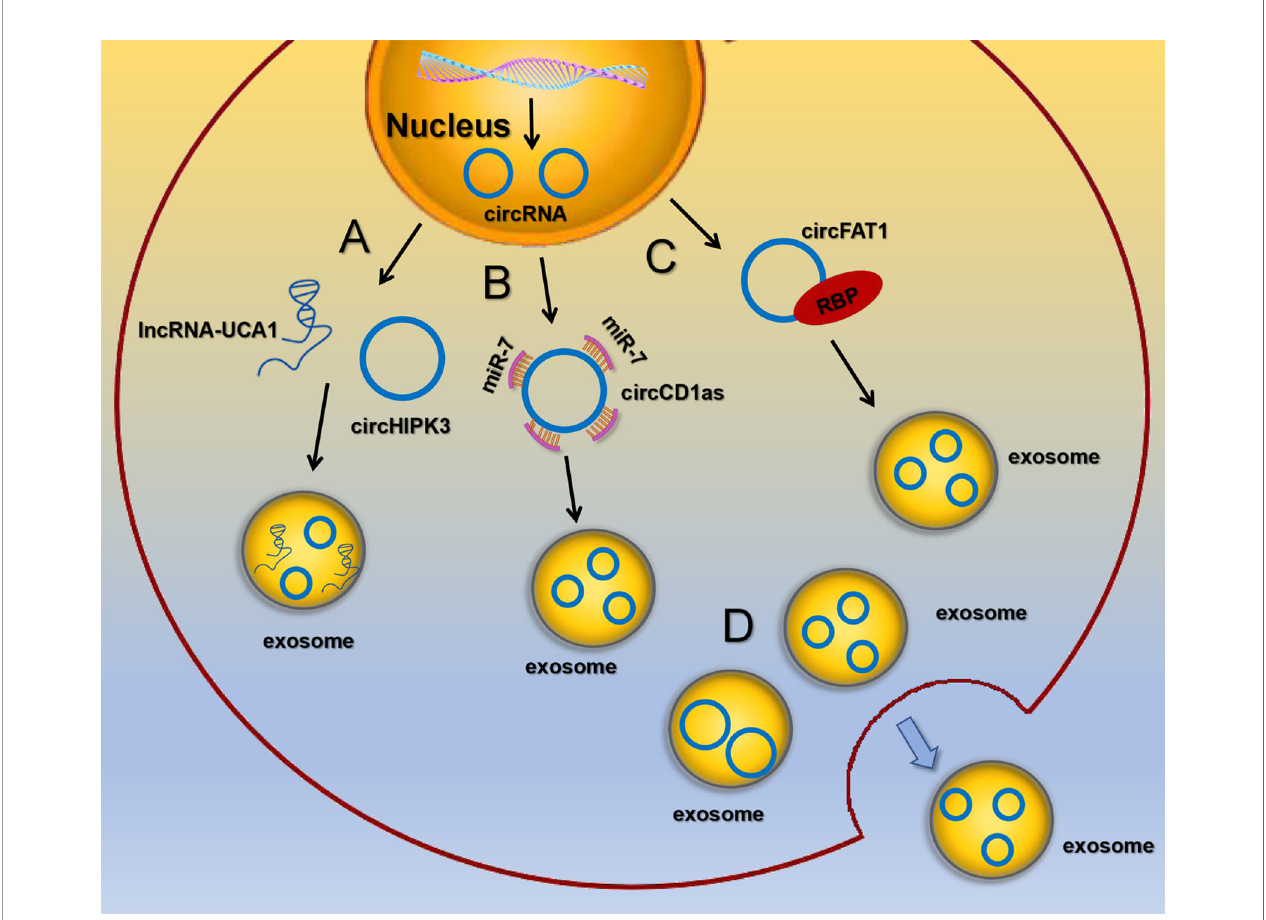
FIGURE 2 | The sorting and secretion mechanisms of circRNA in exosomes (A) lncRNAs competitively regulate circRNAs sorting into exosomes. (B) circRNAs act as miRNA sponges. (C) RBPs recognize RNA with speci fi c binding sequences and regulate the sorting of exosomal circRNAs. (D) Exosomes preferentially release smaller